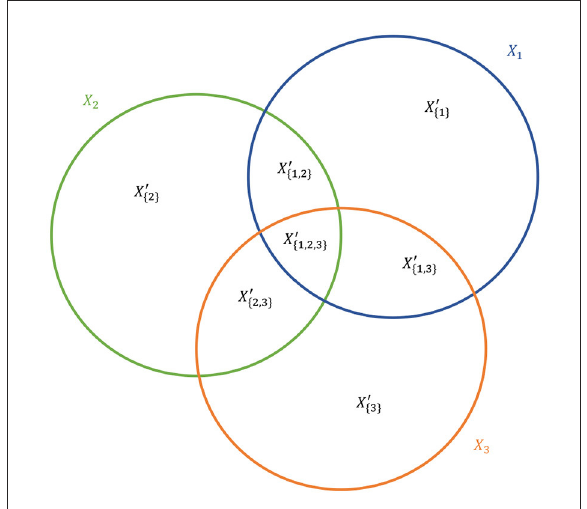
FIGURE1 The naming convention for generating unique, non-overlapping domain parts are identified from X 0 , X 1 , and X 2